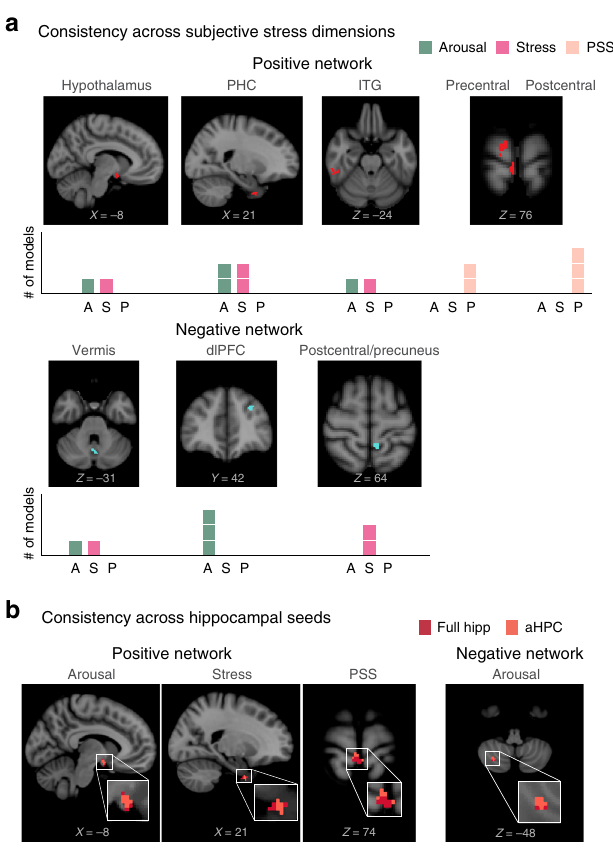
Fig. 5 Consistency of predictive hippocampal connectivity networks. N = 60 participants. a Clusters identi fi ed on every LOO fold as predictive across a signi fi cant number of models. Clusters are shown separately for models predicting higher (positive network) and lower (negative network) stress responses. Bar plots indicate the number of models predicting arousal (A), stress (S), and PSS (P) that included that cluster. b Overlapping clusters predicting the same stress construct across hippocampal